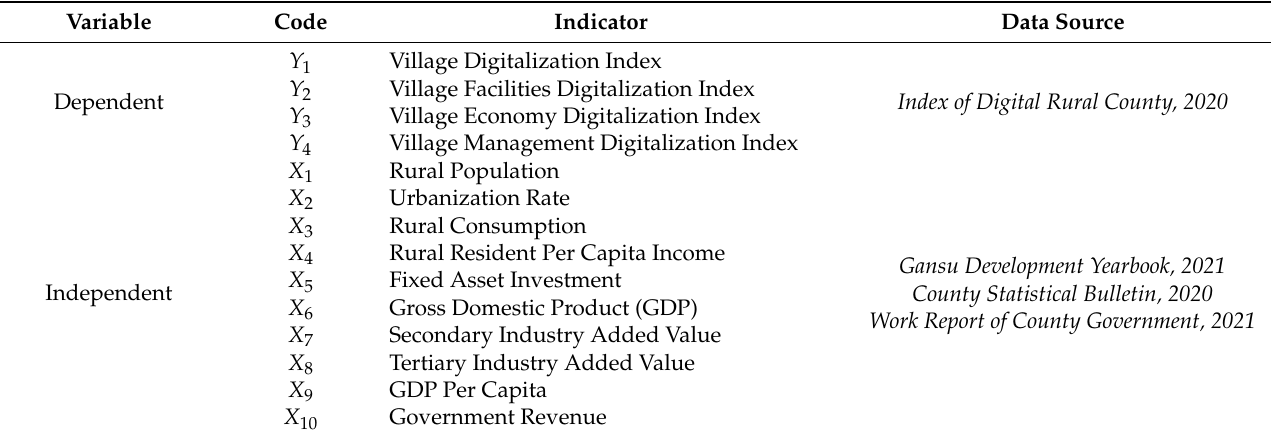
Table 2. Variable composition